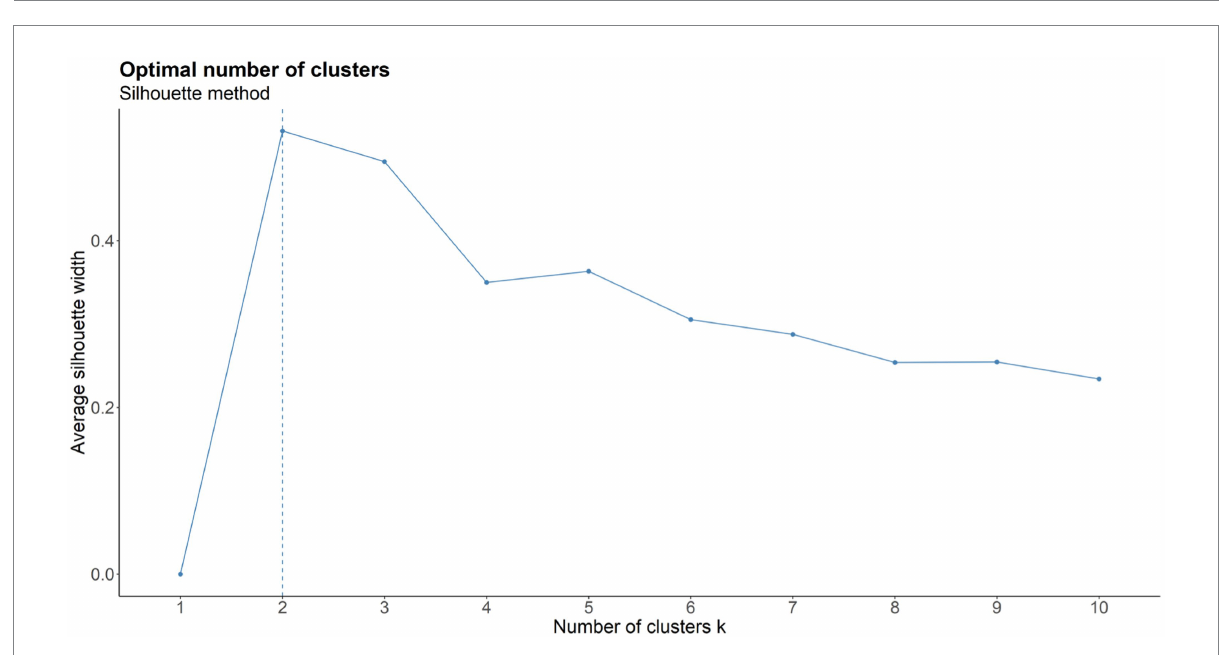
FIGURE 7 Average silhouette method for the selection of optimal clusters.